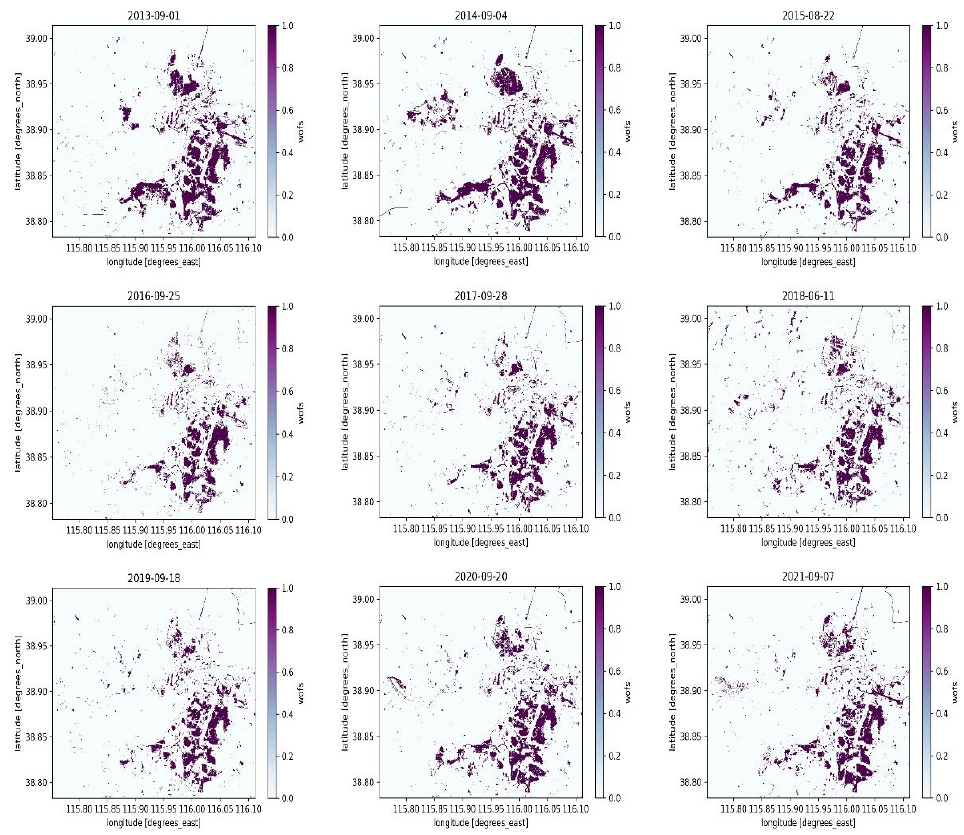
Figure 5. Spatial distribution of water body changes in the Baiyangdian Lake from 2013 to 2021. Figure 6 shows the total number of observable water bodies in the Baiyangdian Lake based on the CDC grid and the WOfS water body extraction algorithm for the 9 years between 2013 and 2021. The values of the total number of observable water bodies are from large to small, in line with the colored bars (dark blue, blue, green, yellow, red) on the right. The darker the colored bars are, the larger are the total number of observable water bodies in the study area. From this, it can be assumed that the change of water body in Baiyangdian Lake is smaller, and its ecological environment is more balanced. The dark-blue area in the purple rectangle at the bottom right of Figure 6 indicates that water has been present in this area for nine consecutive years. In contrast, it can be seen that the light-green areas in the red rectangles presented in the left part, top-right part, and bot- tom-left part of Figure 6 indicate that the values identified as water bodies in these three parts range from one to three, indicating that the Baiyangdian Lake is dynamically chang- ing. More in-depth studies will be carried out later, to determine whether the sizes of the water bodies are increasing or decreasing.